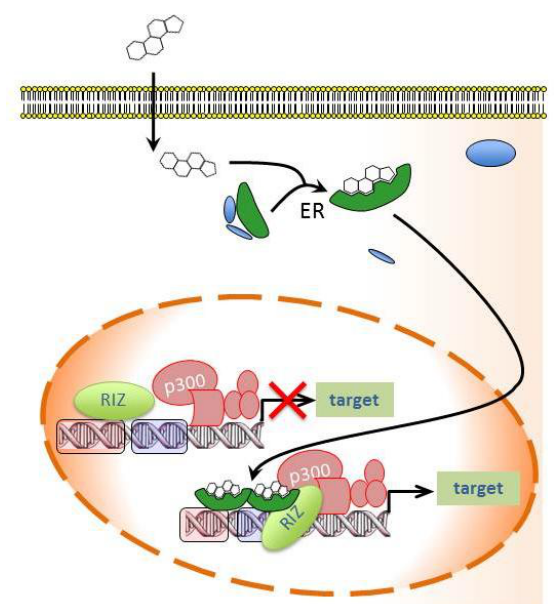
Figure 1. PRDM2 is an estrogen receptor